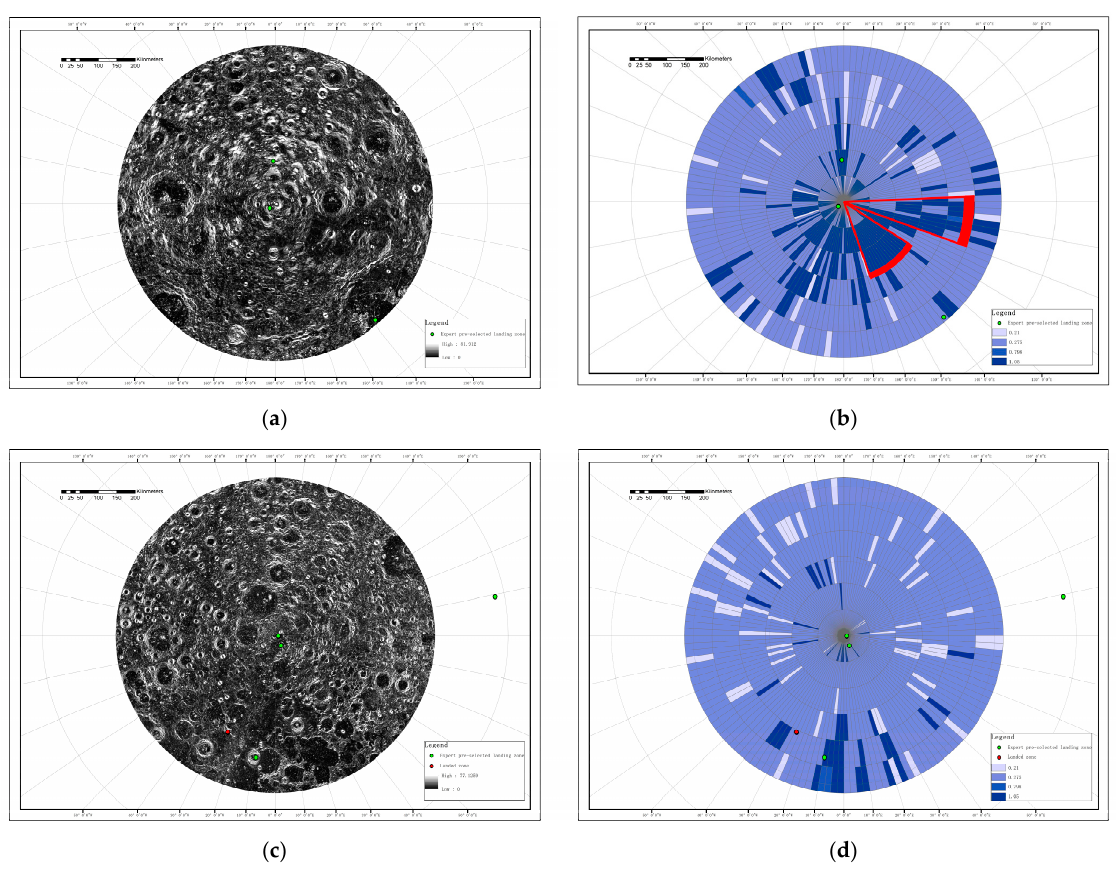
Figure 9. Antarctic and Arctic slope and posterior probability map. ( a ) Antarctic slope data; ( b ) Antarctic posterior probability result; ( c ) Arctic slope data; ( d ) Arctic posterior probability result.